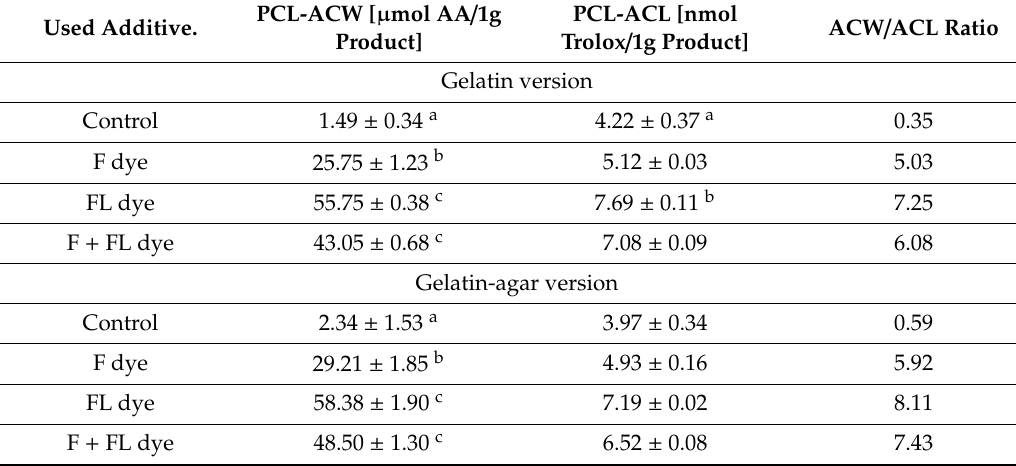
The content of hydrophilic and hydrophobic antioxidants in tested jellies [photochemiluminescence (PCL)